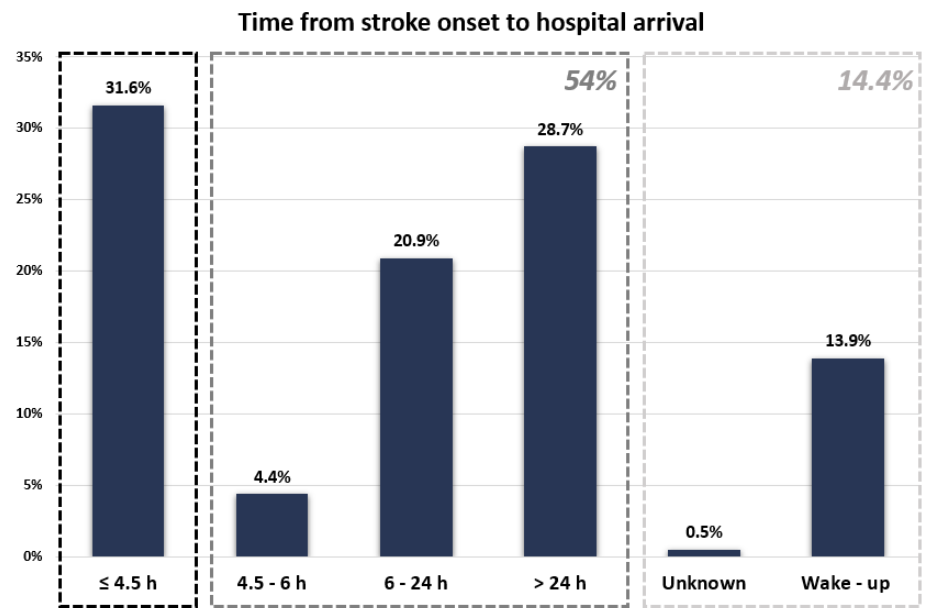
Figure 2. Time between stroke onset and hospital arrival for the study